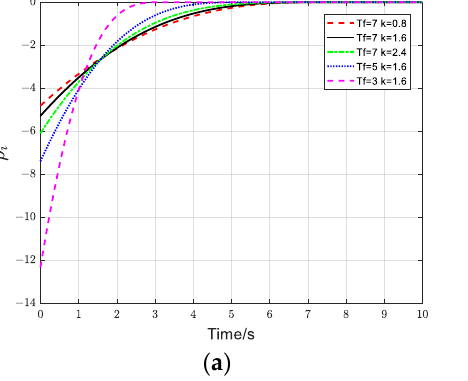
. ρ for five cases; ( b ) the curves of i